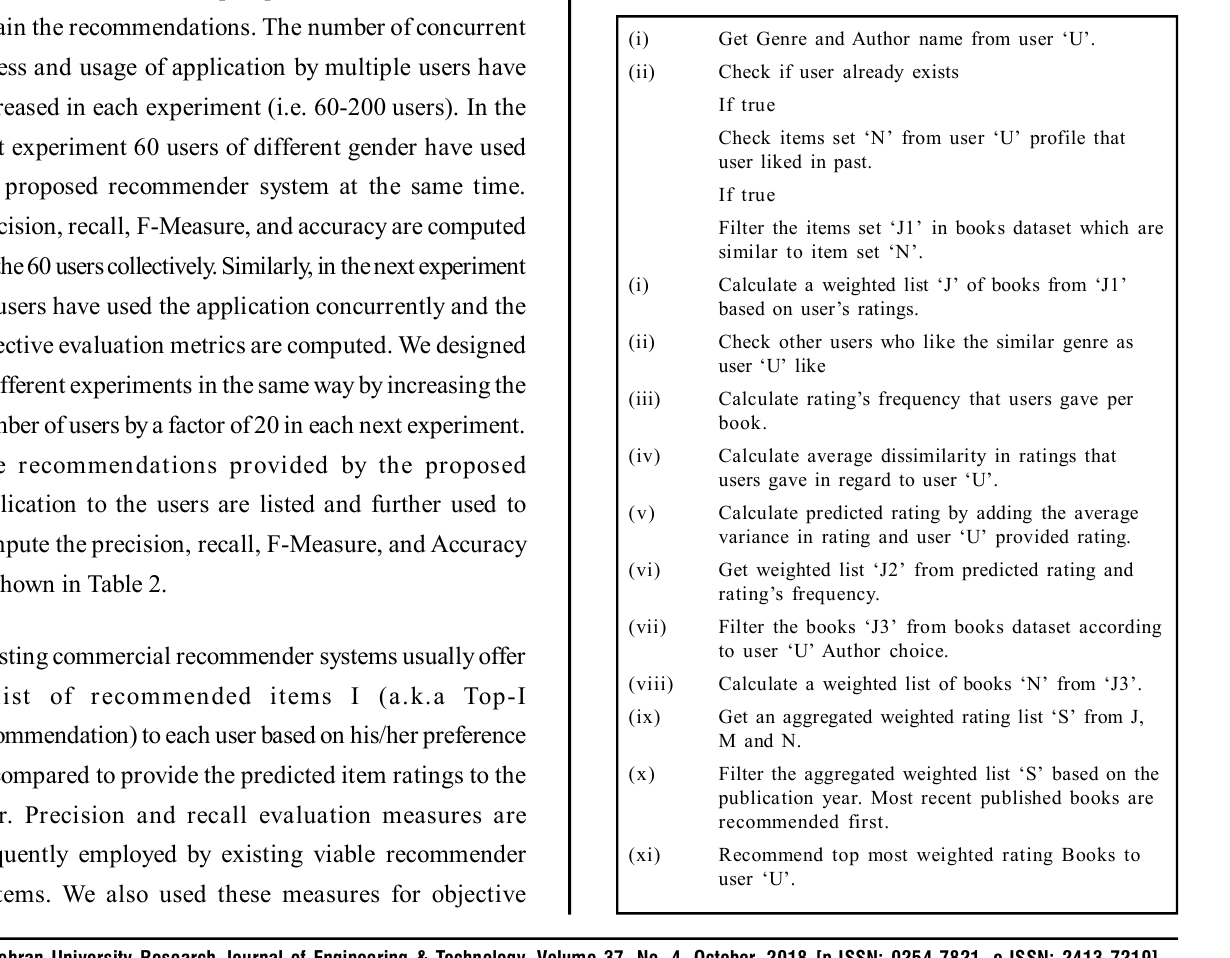
TABLE 2. OBJECTIVE EVALUATION OF THE PROPOSED HYBRID RECOMMENDATION